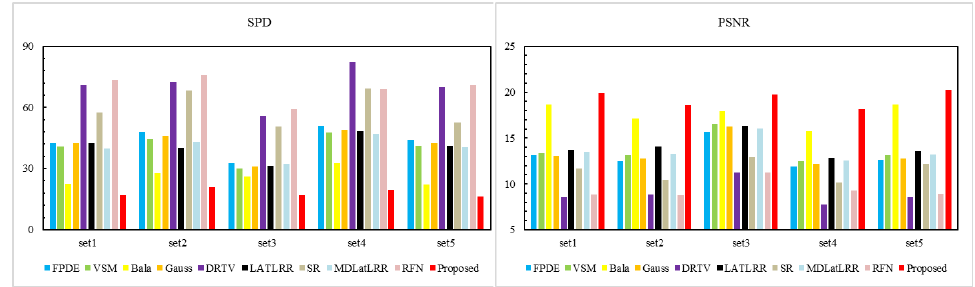
Figure 9. Quantitative results of six evaluation parameters. The nine methods, i.e., FPDE, VSM, Bala, Gauss, DRTV, LATLRR, SR, MDLatLRR, RFN are compared with the proposed method.